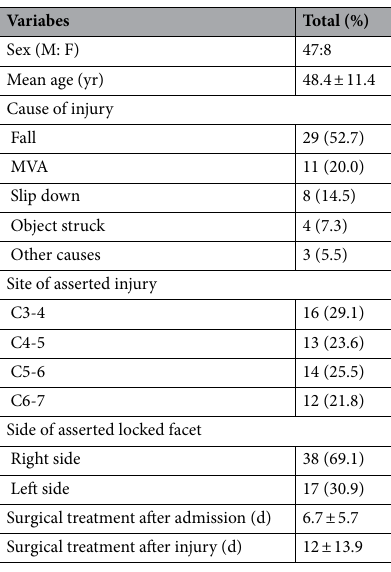
Table 1. The demographic data of the patients with UCLF. MVA, motor vehicle accident; M, male; F,